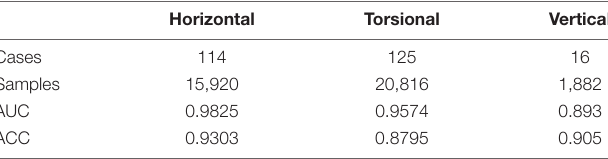
TABLE 2 | Model performance in detecting horizontal, torsional, and vertical